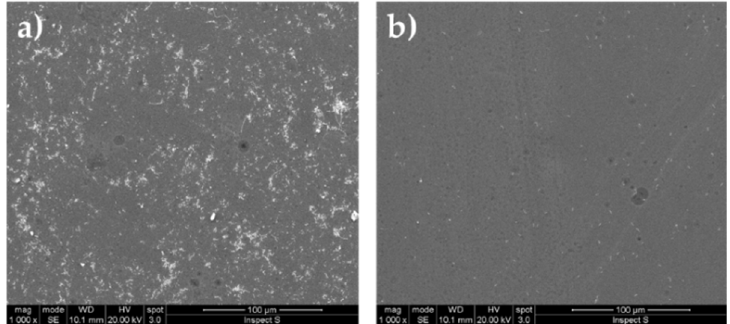
Figure 14. Controls. Adhesion on untreated glasses of bacteria: ( a ) BC 658 (Gram-) ( b ) BC 660 (Gram+).